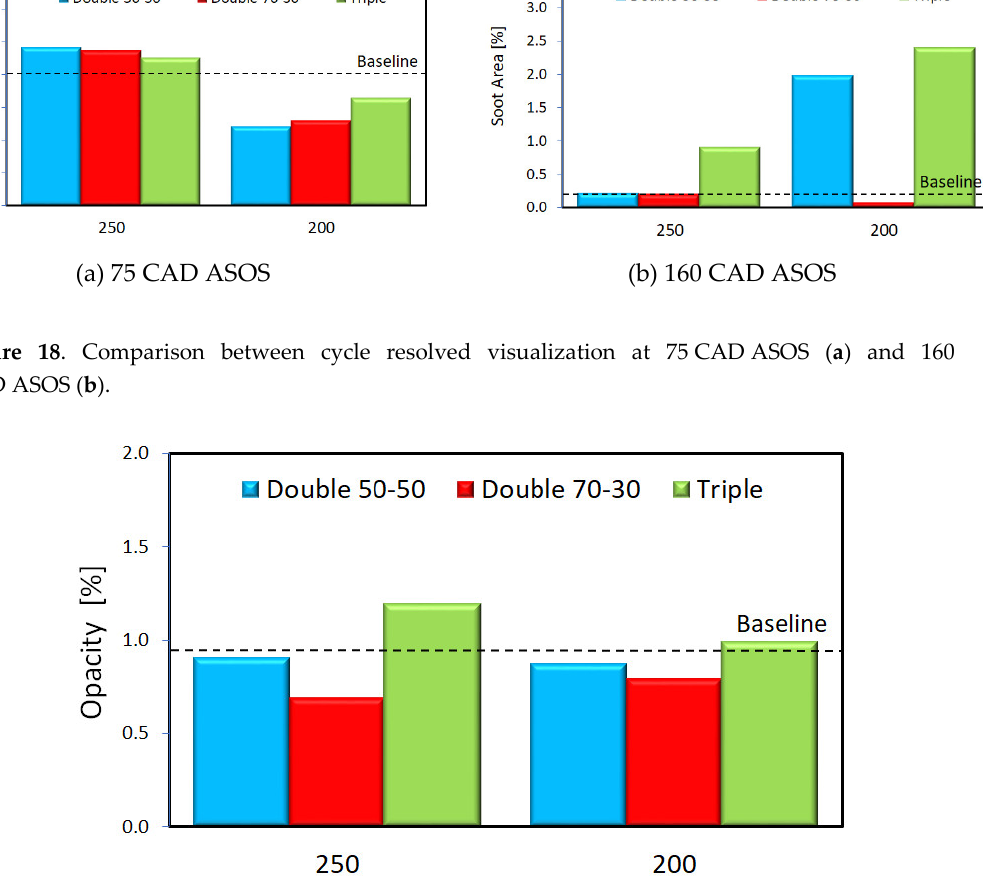
Figure 19 . Opacimeter results in the pipe